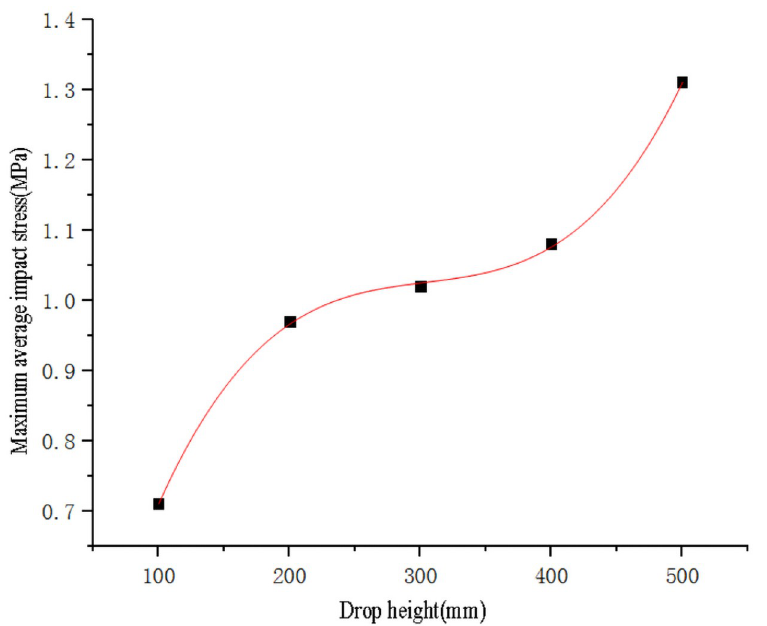
Fig 11. Fitting curve of sweet potato drop height and impact stress.